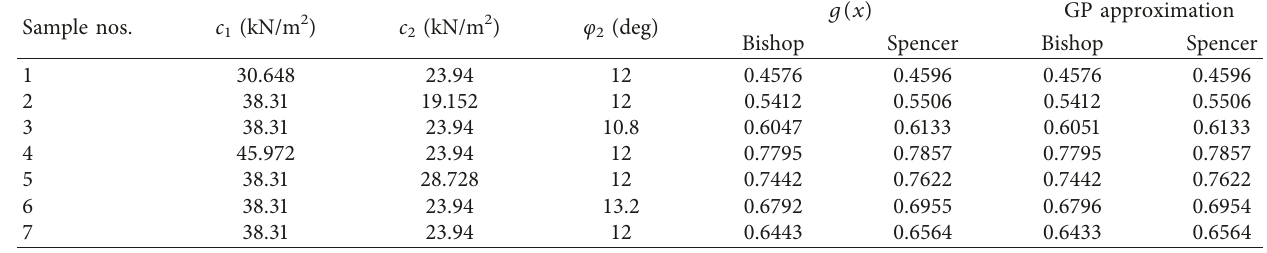
Table 5: The initial learning samples of Example 2.